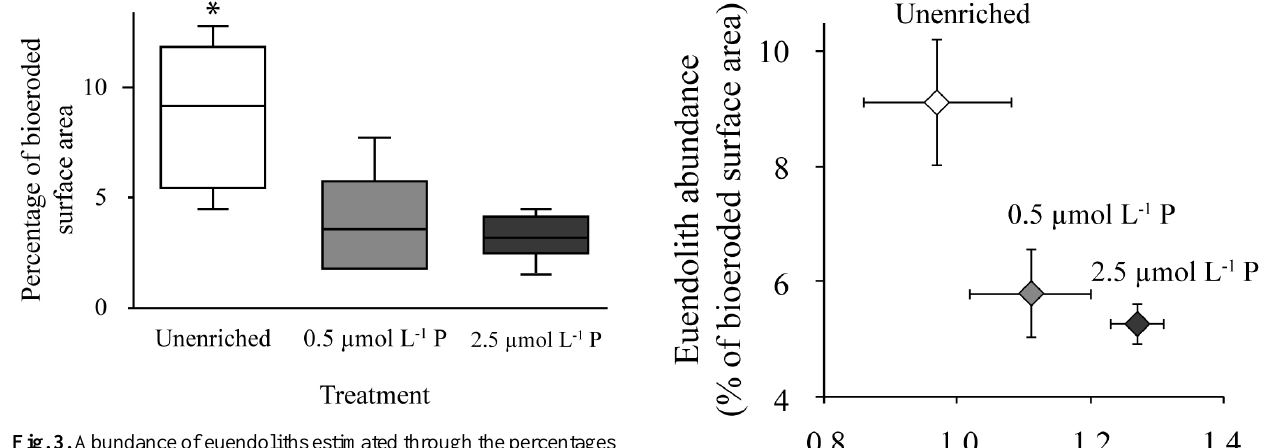
Fig. 3. Abundance of euendoliths estimated through the percentages of surface area bioeroded in each phosphate treatment. Data are pre- sented as Tukey box plots calculated on n = 150 measurements per treatment. The star indicates treatments significantly different from the others.